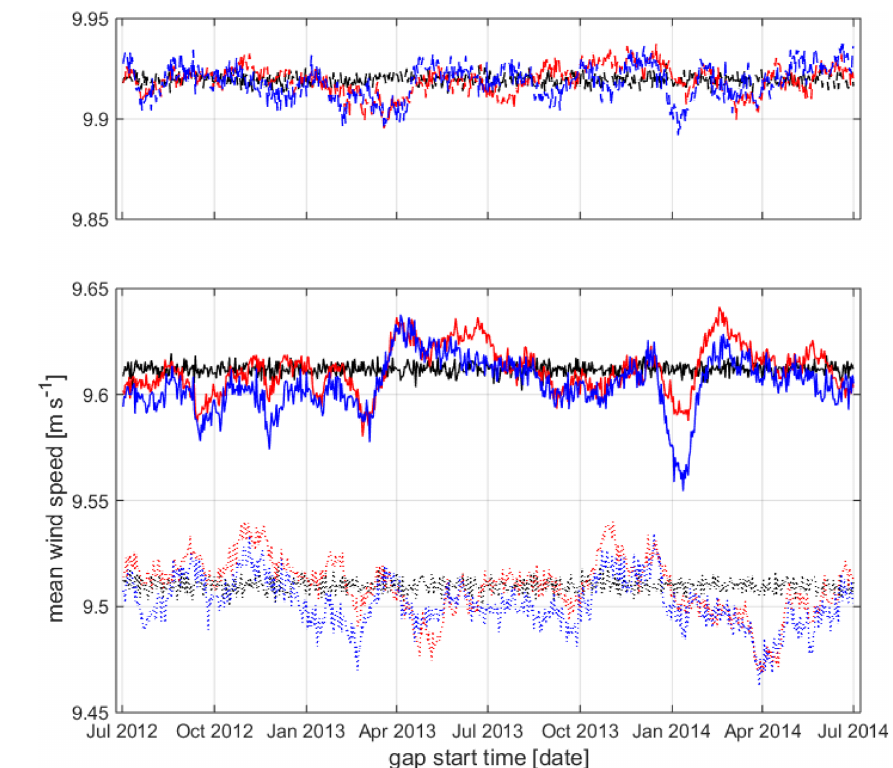
Figure 11. Variation in long-term corrected mean wind speed depending on start date of the artificial 30d gap in short-term measurements. Results for FINO3 as solid lines, for IJmuiden as dashed lines and for FINO2 as dotted lines (again for incomplete short-term measurement time series in red and for filled time series in blue and for measurements without gap in black as